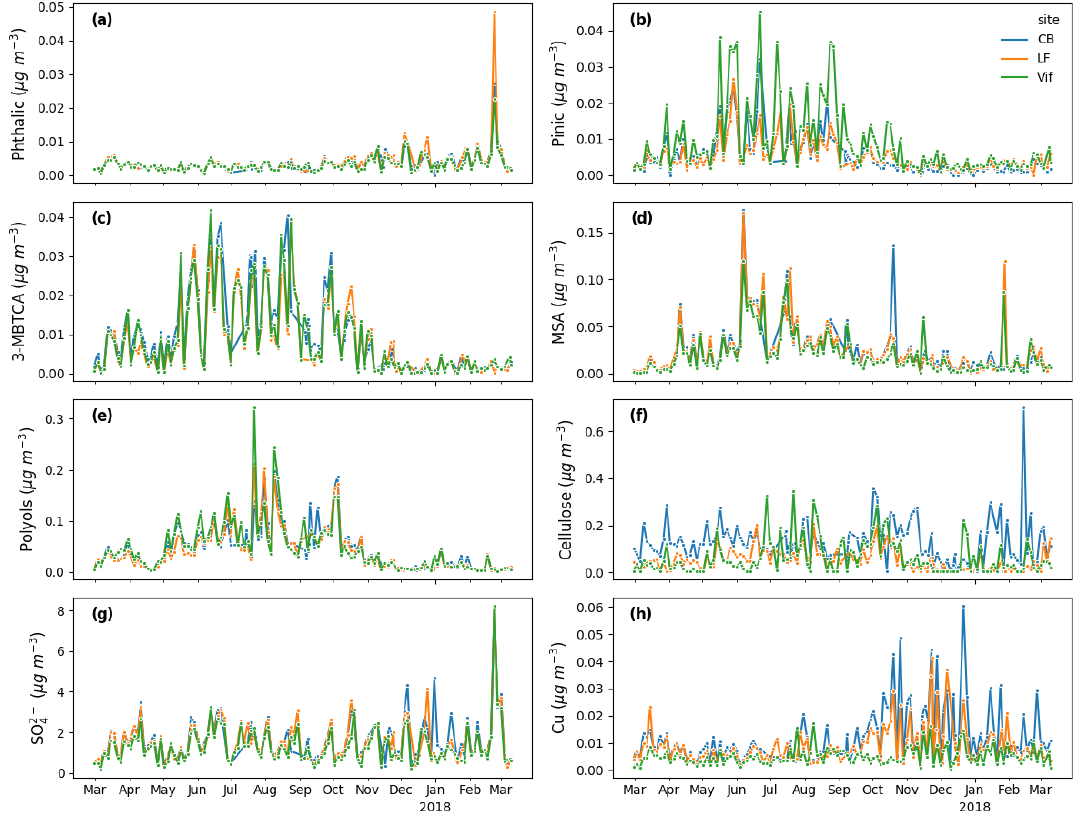
Figure 2. Temporal evolutions of (a) phthalic acid, (b) pinic acid, (c) 3-MBTCA, (d) MSA, (e) polyols (arabitol + mannitol), (f) cellulose, (g) SO 2 − and (h) Cu in the three urban sites in the Grenoble basin (LF in orange, CB in blue, and Vif in green). 4